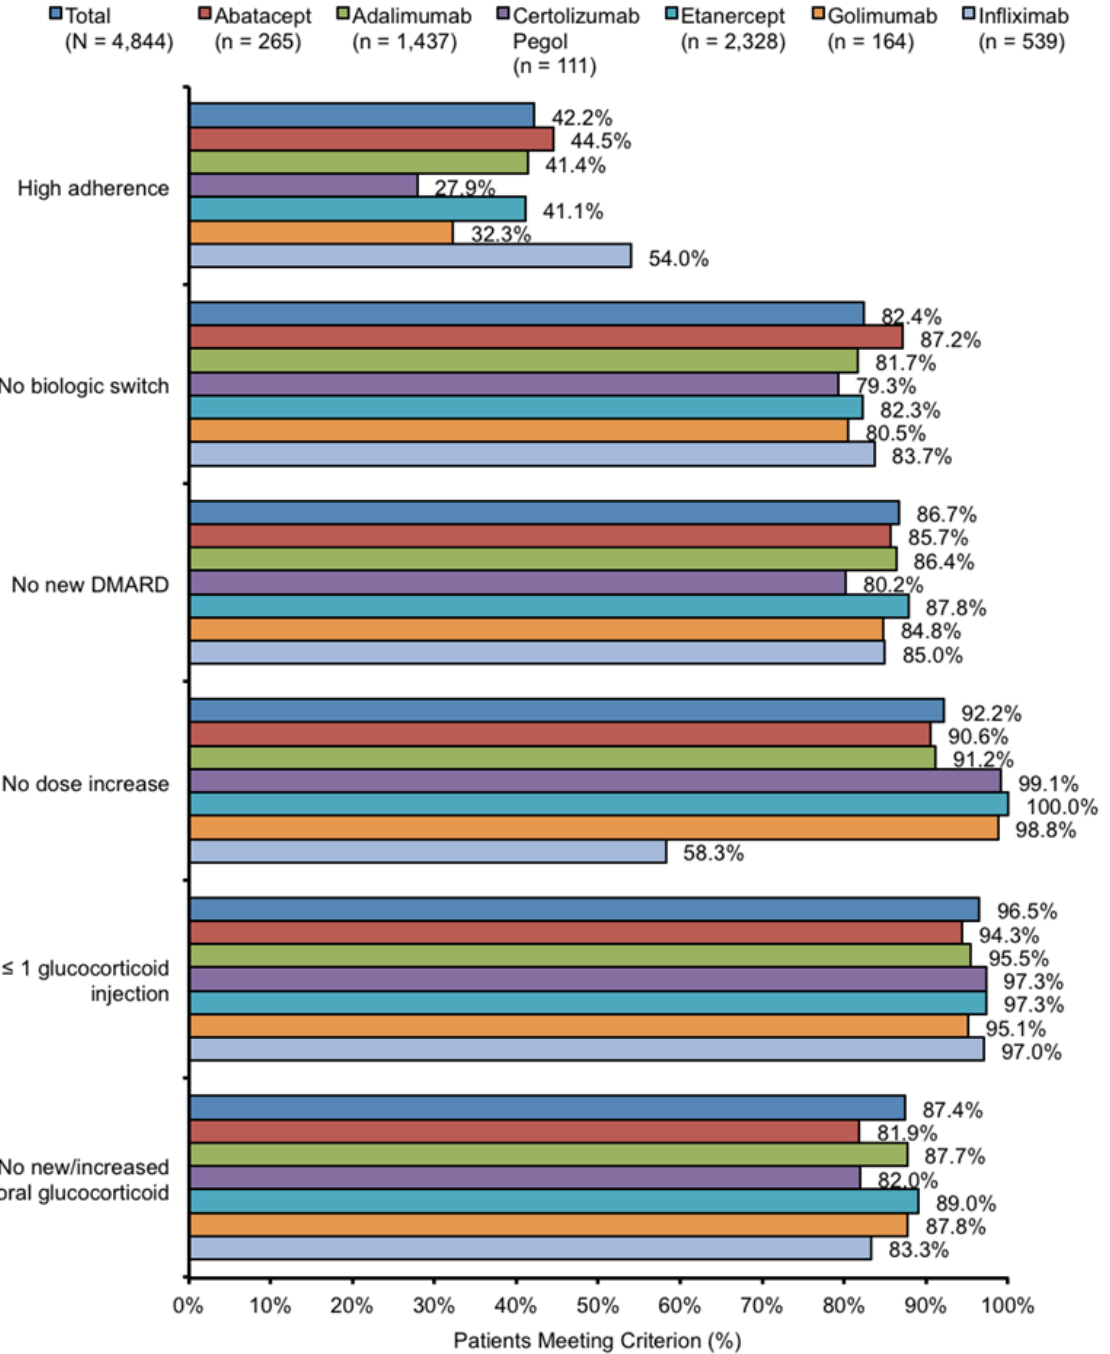
Patients were more likely to fail the criteria for high adherence and no dose increase than the other algorithm criteria Statistical comparisons were not conducted at the individual criteria level DMARD: disease-modifying antirheumatic